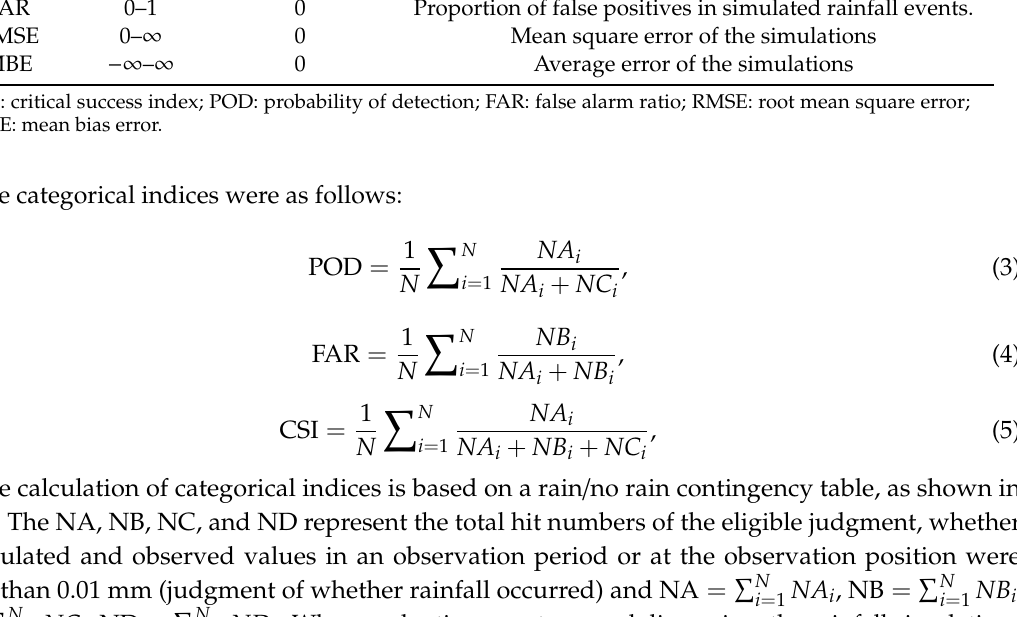
the simulated and observed values in an observation period or at the observation position were greater than 0.01 mm (judgment of whether rainfall occurred) and NA =